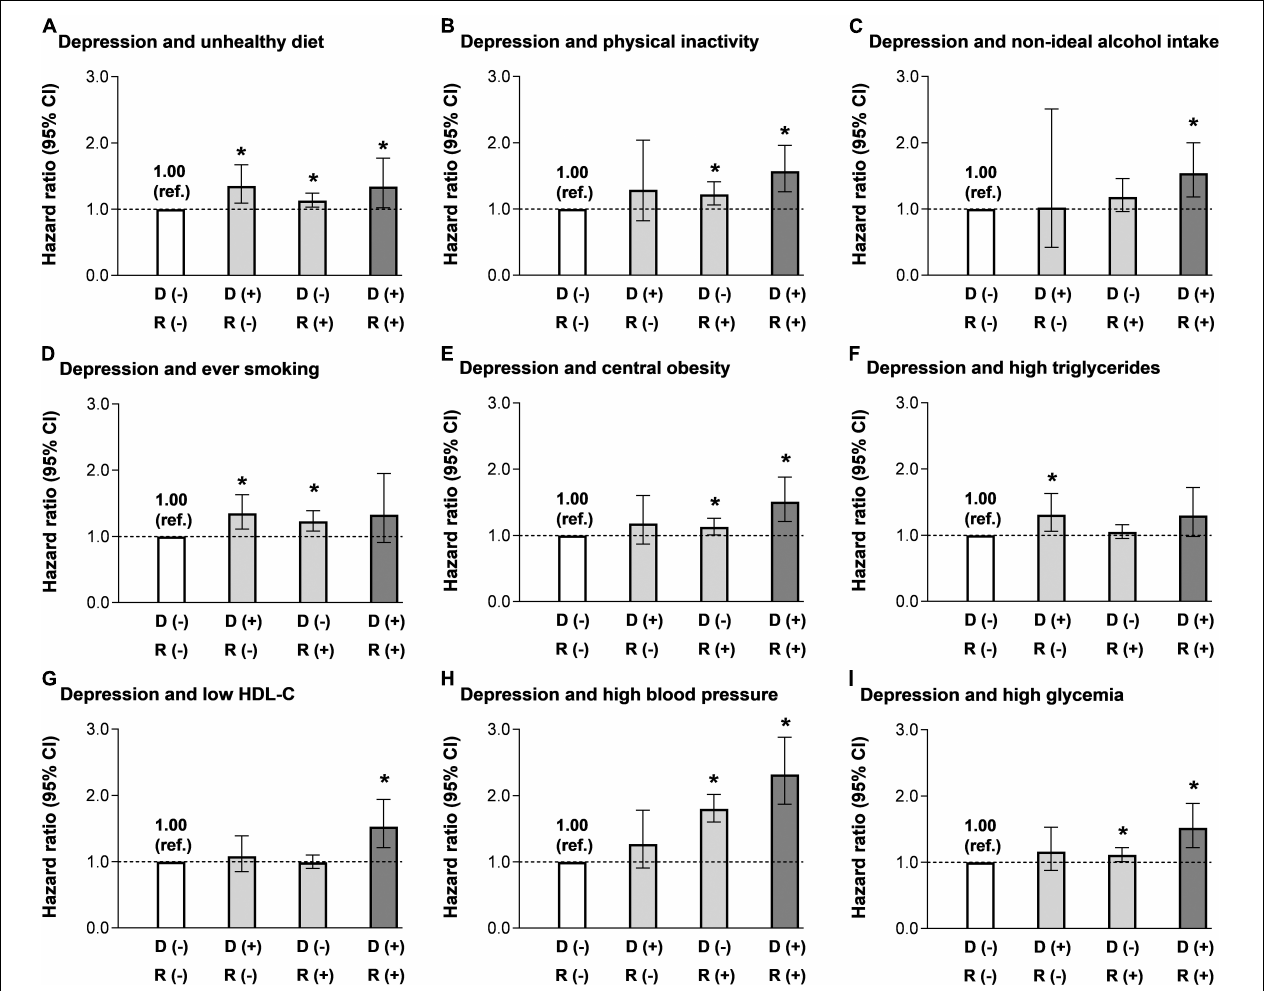
FIGURE 1 | Multivariable-adjusted hazard ratios (HRs) [95% confidence indices (CIs)] for major cardiovascular disease (CVD) events according to the combination of depression and other lifestyle and metabolic risk factors. (A) Groups according to the combination of depression and unhealthy diet. (B) Groups according to the combination of depression and physical inactivity. (C) Groups according to the combination of depression and alcohol intake. (D) Groups according to the combination of depression and smoking status. (E) Groups according to the combination of depression and central obesity. (F) Groups according to the combination of depression and high triglycerides. (G) Groups according to the combination of depression and low high-density lipoprotein cholesterol (HDL-C). (H) Groups according to the combination of depression and high blood pressure. (I) Groups according to the combination of depression and high glycemia. Adjusted for age, sex, education attainment (below high school, high school, or above), marriage status (married, single, divorced, or widow), dwelling status (living alone, or not), family history of CVD (yes or no), and body mass index (BMI). Individual lifestyle and metabolic risk factors were mutually adjusted. D (–): without depression symptom; D (+): with depression symptom; R (–): without the specific combined risk factor; R (+): with the specific combined risk factor. * P < 0.05 compared with the reference